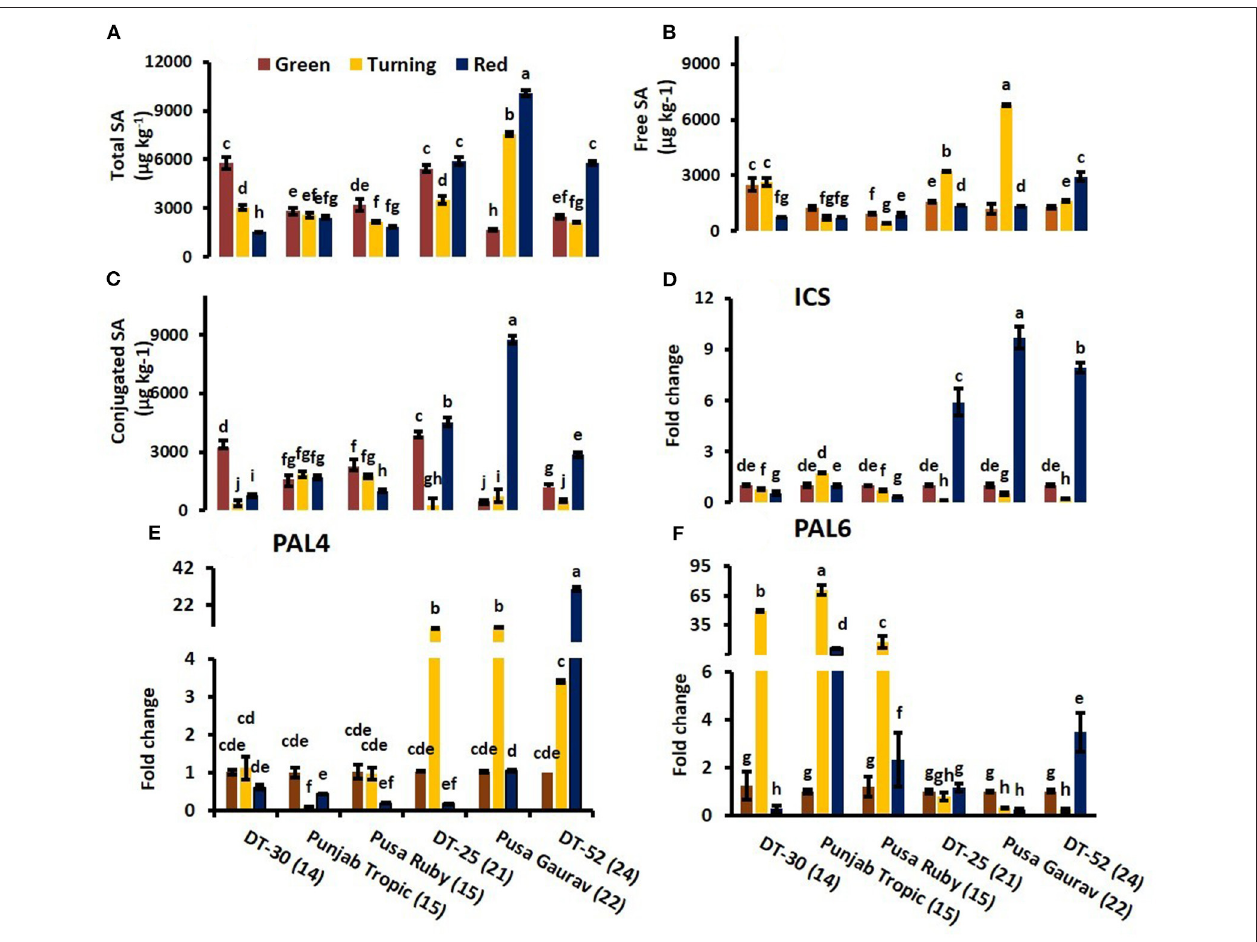
FIGURE 5 | Relative expression of SA biosynthesis enzymes viz. Isochorismate Synthase (D) , Phenylalanine Ammonia Lyase 4 (E) and Phenylalanine Ammonia Lyase 6 (F) in relation to total endogenous SA (A) , free SA (B) and conjugated SA (C) level at turning and red stage. Bottom axis represents name of tomato lines and numbers enclosed in parenthesis represents shelf life. The expression data of green stage fruit were normalized to a value of 1. Each value represents the mean ± S.E. of three replicates. Different letters represent significant differences at P <